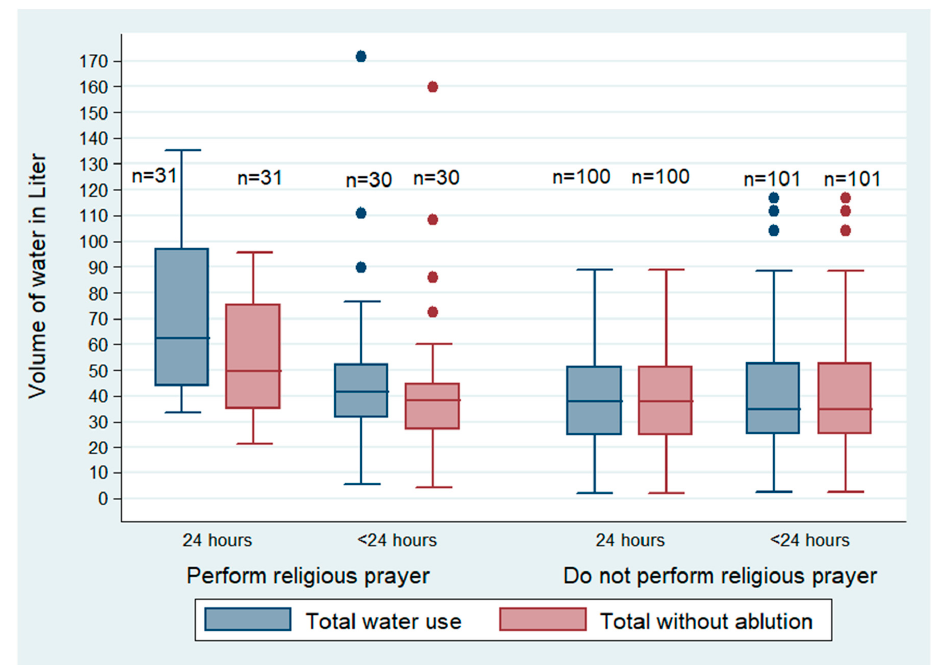
Figure 3. Water used, LCPD) for personal hygiene between religious performers and non-performers by water availability of the low-income urban residents of Arichpur, Dhaka, from May 2015 to March